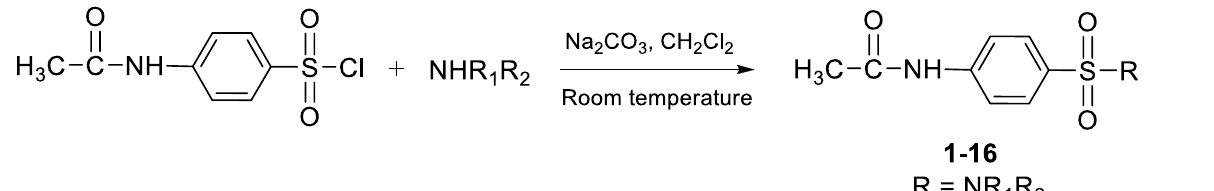
Figure 1: Synthesis of sulfonamide derivatives ( 1 - 16